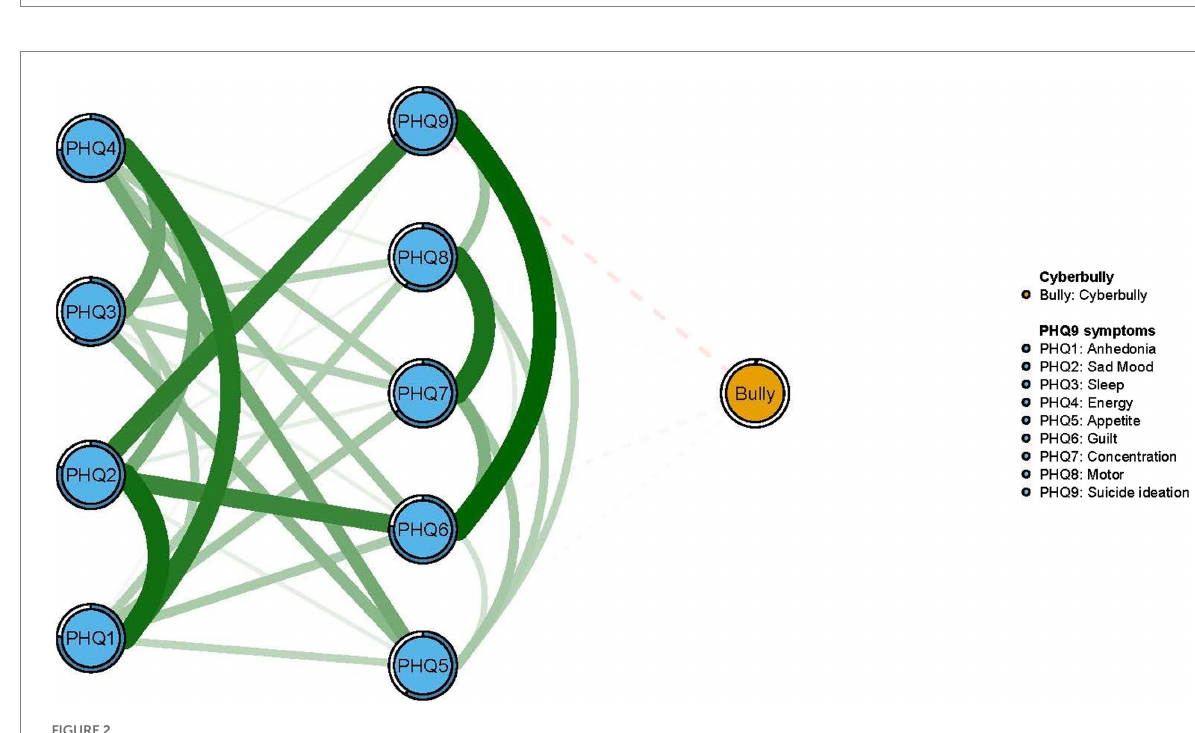
FIGURE 2 Flow network of cyberbully and residual depressive symptoms.